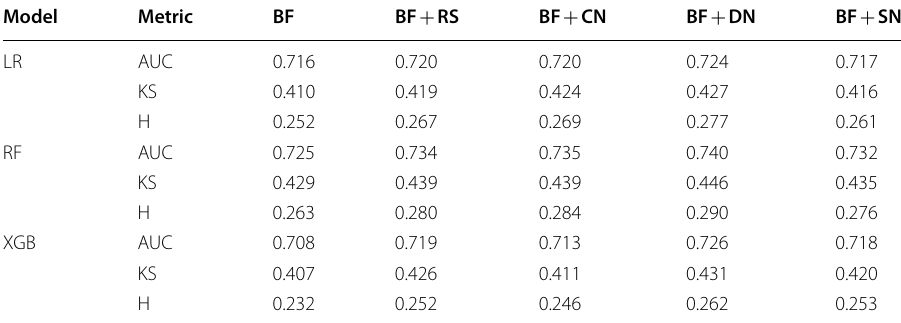
Each metric is measured by the mean of 100 estimates obtained by repeating the outer ten-fold cross-validation procedure ten times